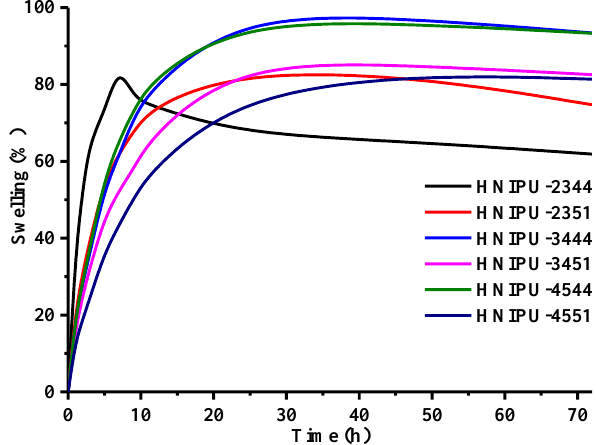
Figure 7. Swelling behavior of the different HNIPUs in dimethylsulfoxide (DMSO).